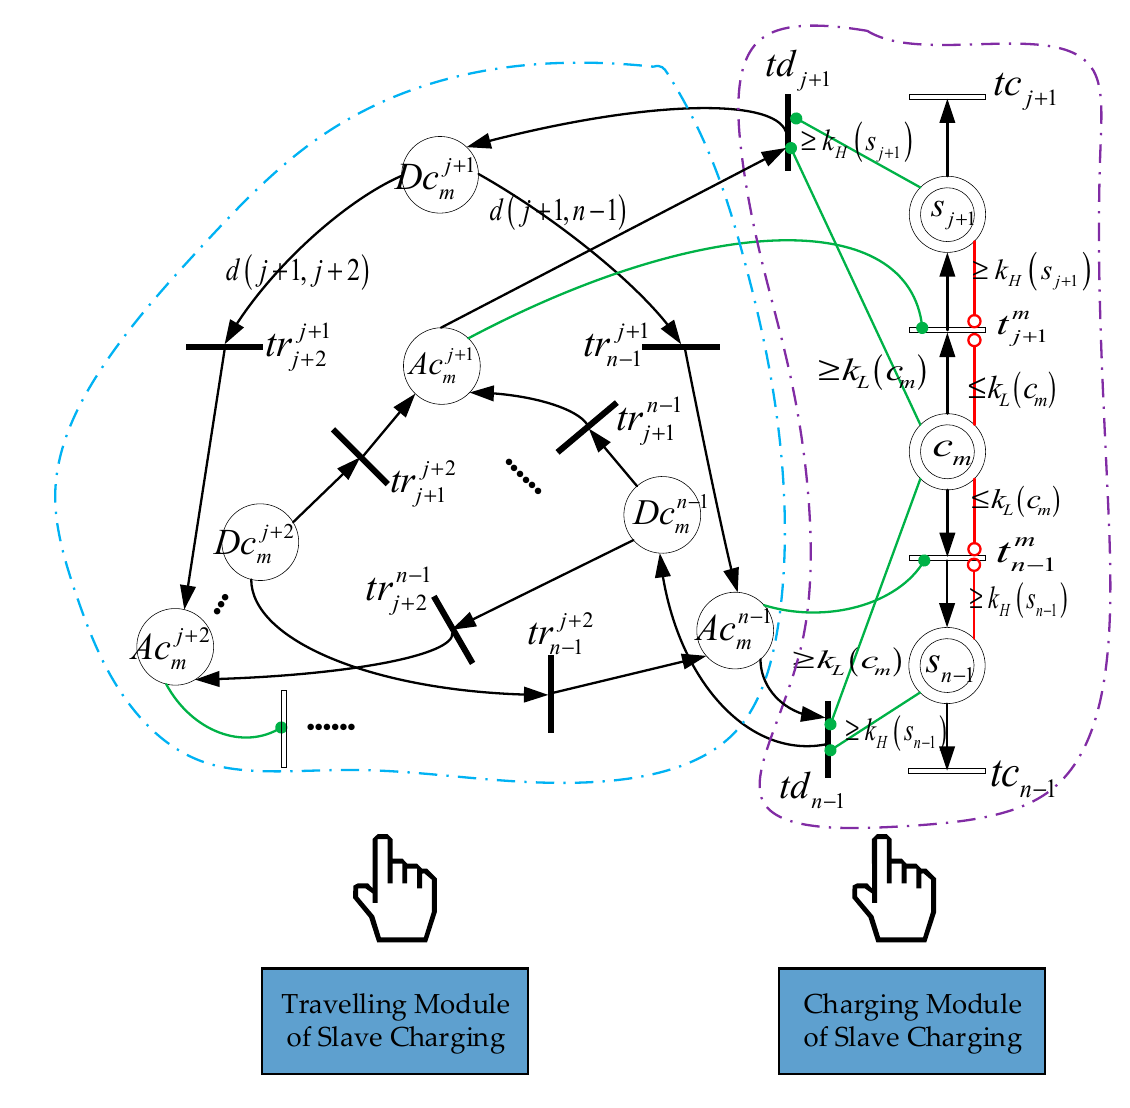
Figure 6. Mobile charging subnet. Table 2. Interpretation of place and transition for fixed charging subnet.